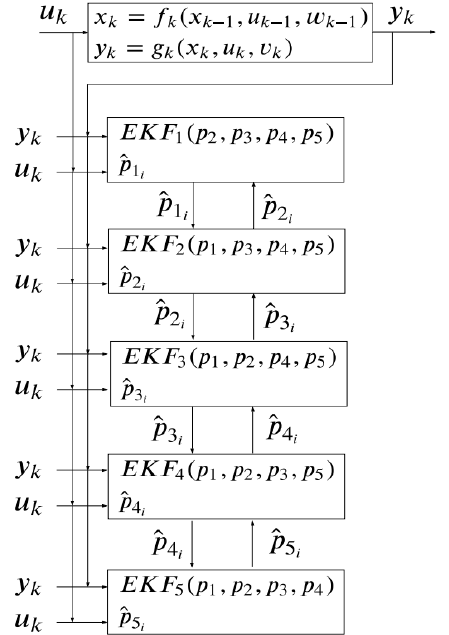
Figure 1. Block diagram and illustration of the EKF-based parameter estimation